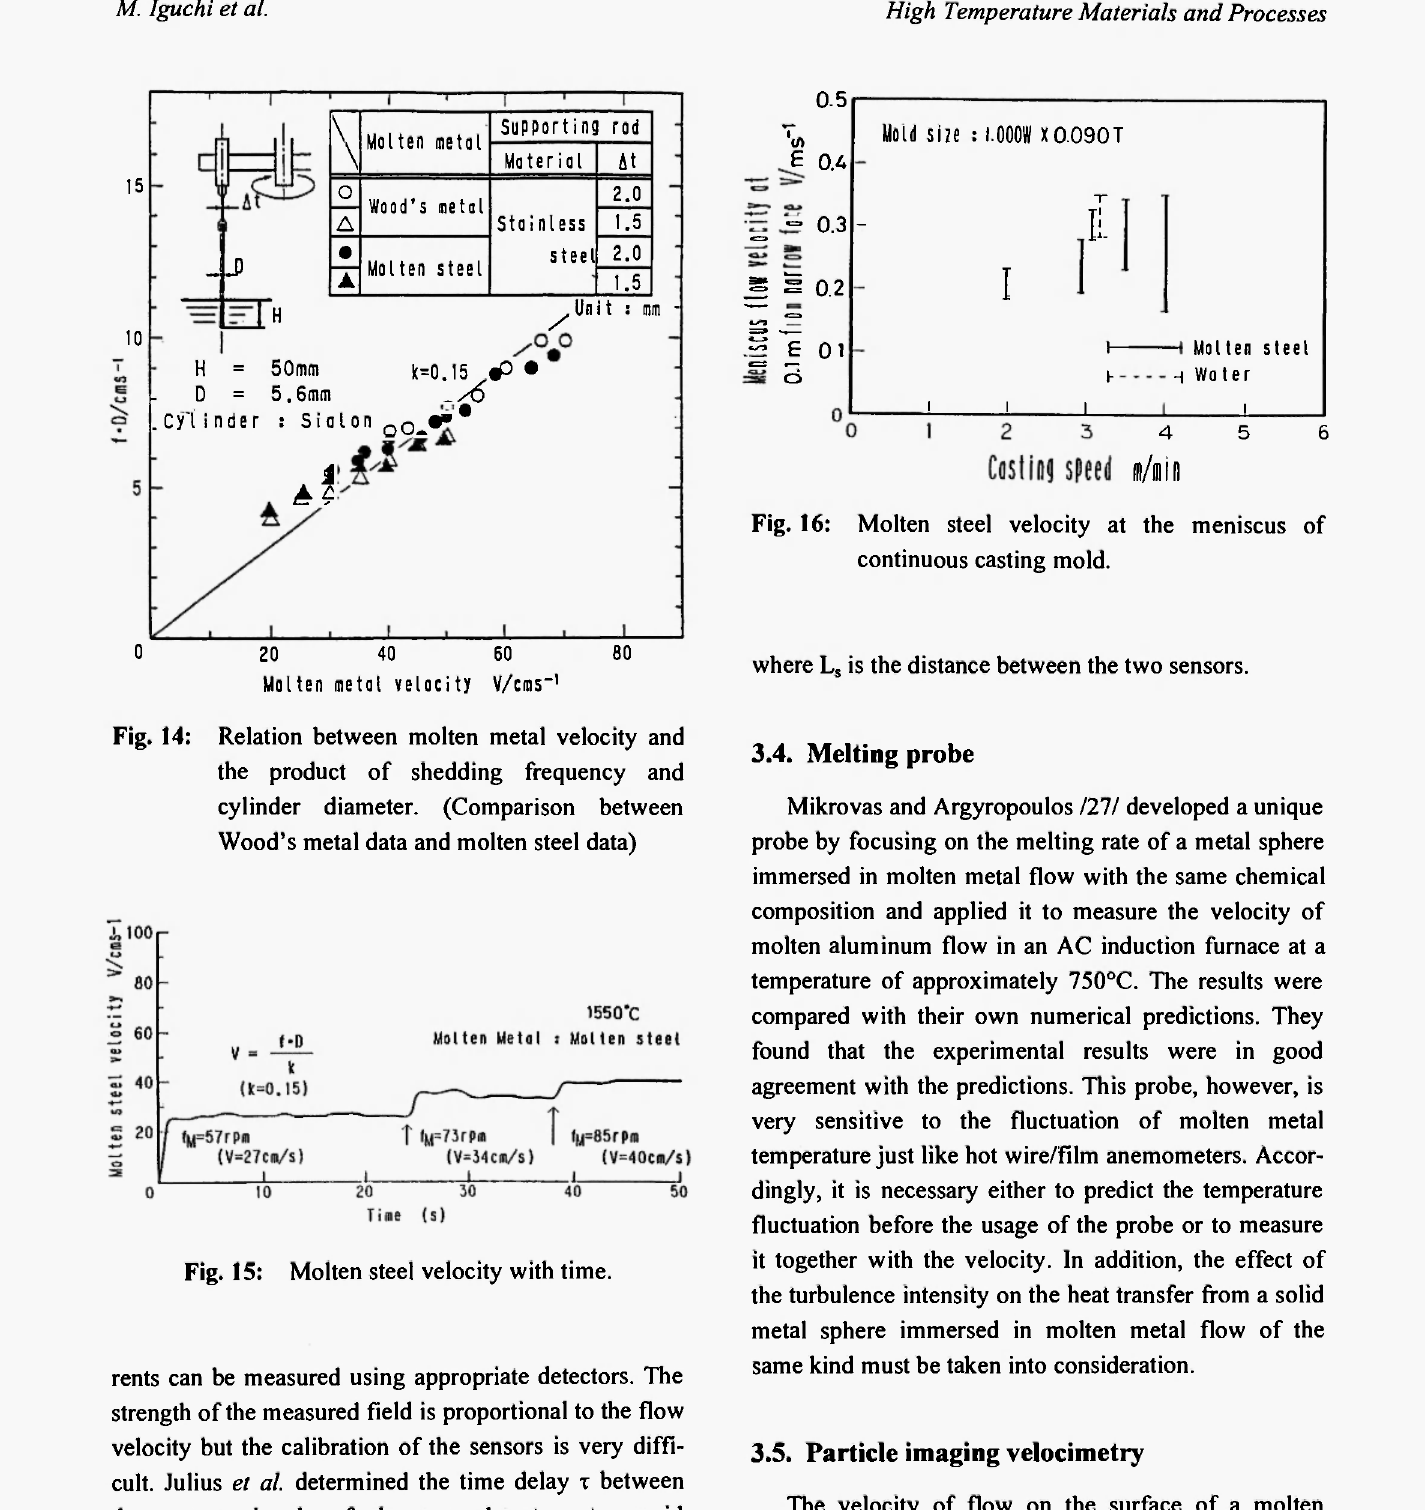
Fig. 15: Molten steel velocity with